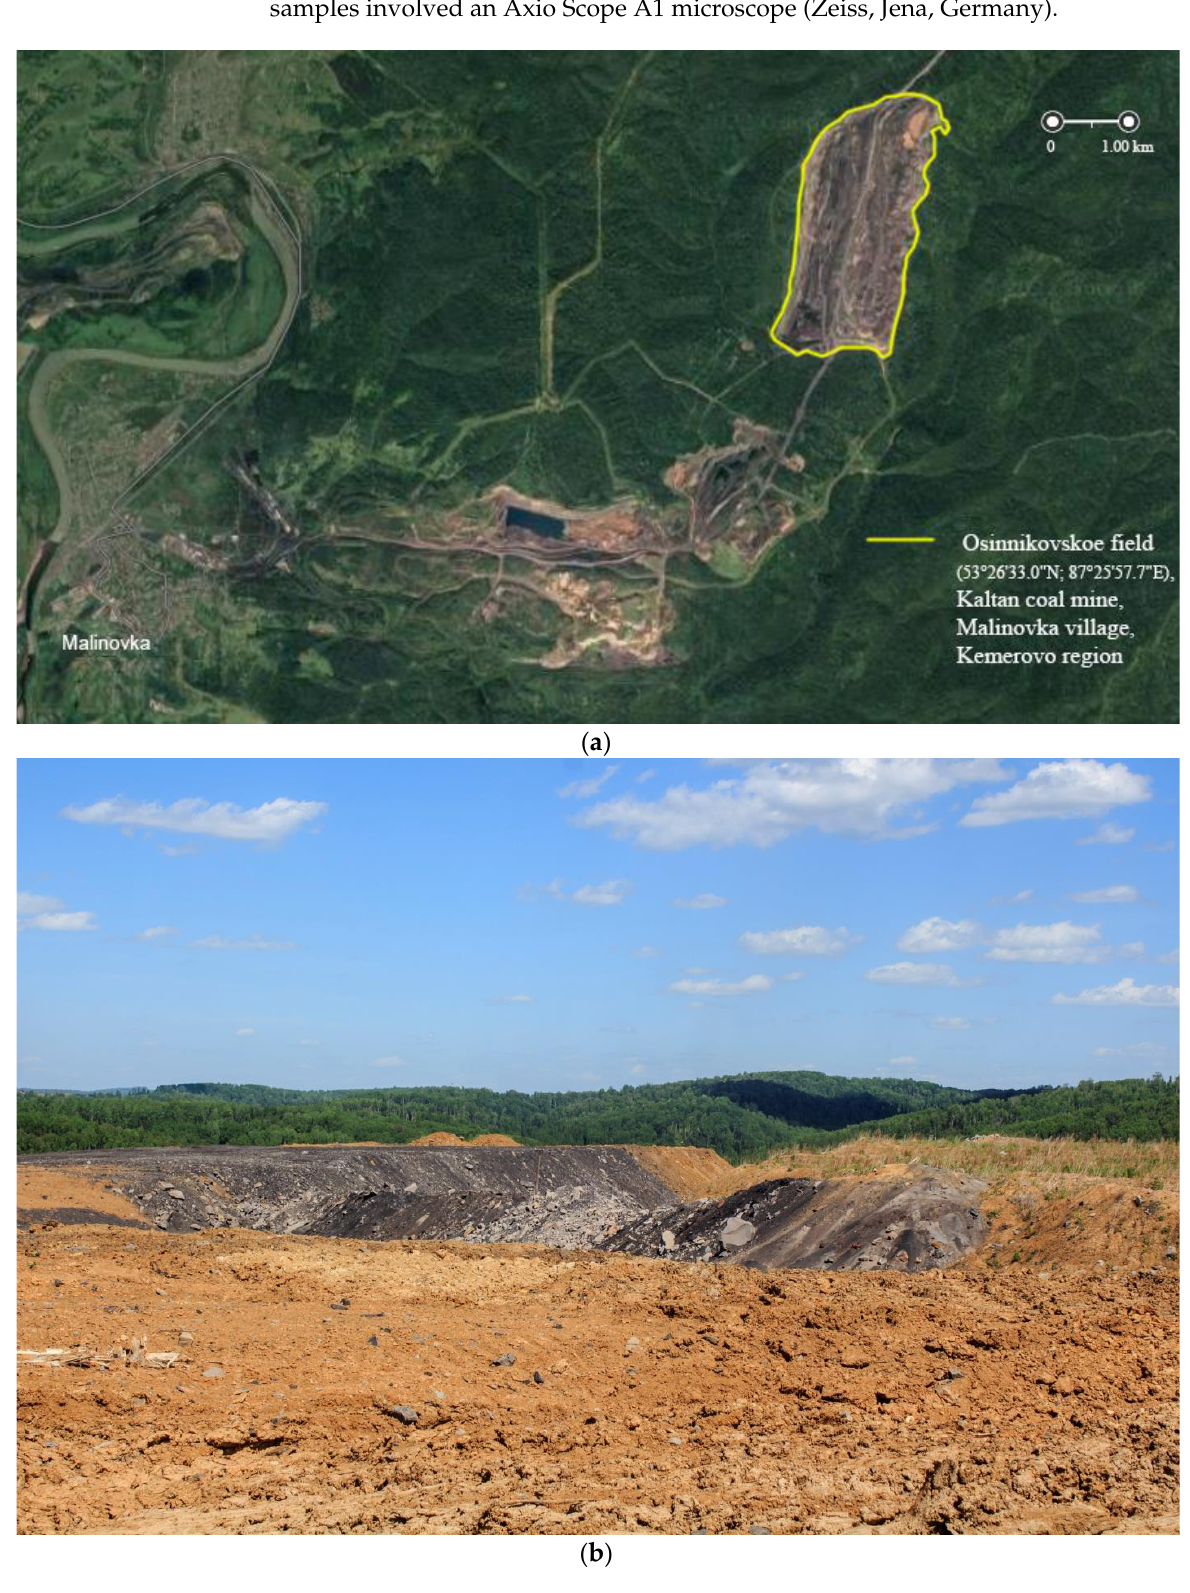
Figure 1. Photo of the Osinnikovskoye coal deposit: ( a ) public cadastral map, ( b ) snapshot of the field.